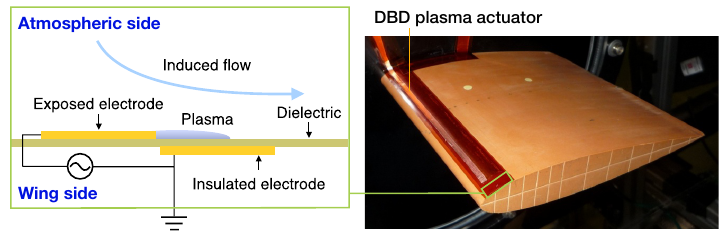
Figure 1. Schematic diagram of the DBD plasma actuator and an example of the practical application. In this study, dynamic burst actuation for the enhancement of the flow control au- thority of plasma actuators is proposed. To identify the effectiveness of the dynamic burst actuation, the three-dimensional compressible Navier–Stokes equations with the DBD plasma actuator body force terms were solved by an implicit large-eddy simulation (iLES), and the results are discussed. The plasma actuator was installed at a 5% chord position from the leading edge of the airfoil with a cross-section of an NACA0015 airfoil. The Reynolds number was set to 63,000, and post-stall angles of attack of α = 12 or 16 degrees were considered. A single-point pressure sensor was installed at a 40% chord position in the middle of the airfoil span. The separated flows were controlled by the DBD plasma actuator, where the AC voltage was modulated with the duty cycle not given a priori, but dynamically changed based on the measured pressure fluctuations given by the point sensor. Two modulation strategies were considered [29,30]. The present approach realizes effective dynamic burst frequency automatically with little additional cost. Application to the case at a higher angle of attack highlighted the robustness of one of the approaches presented